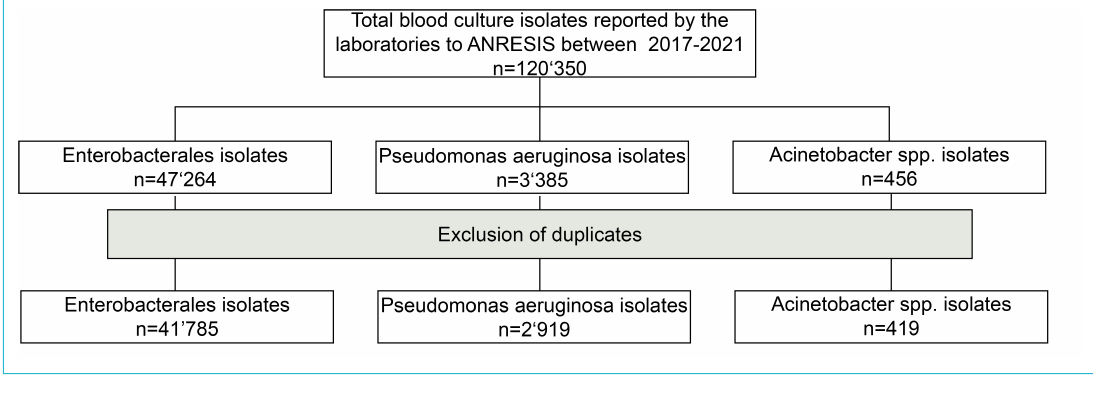
Figure S1: Flowchart of the selection process of isolates submitted to ANRESIS between 2017 and 2021.